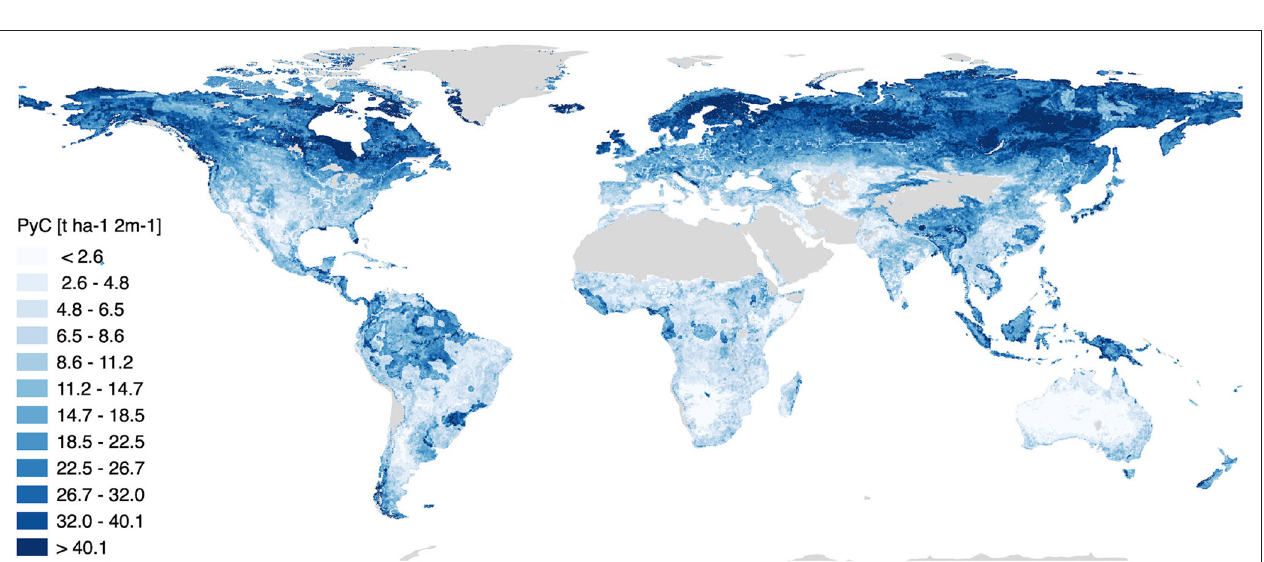
FIGURE 9 | Global predicted PyC content as mass % of the total SOC. Explained variance by the used linear model is 33%. Variables used were clay content, pH, mean annual precipitation, mean annual temperature, and land use. Land mass is colored in gray.